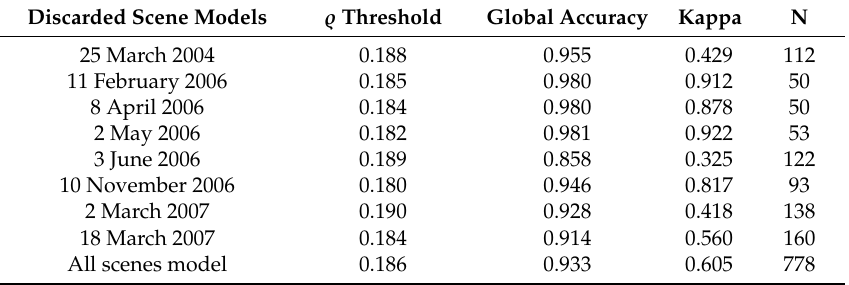
Table 3. Band 5 reflectance thresholds estimated from classification trees on the set of training Landsat images. Kappa and global accuracy values for every classification tree are also provided. Dates in the first column indicate the discarded scene for every cross-validation model. The total number of ground-truth points (N) used for validation is also